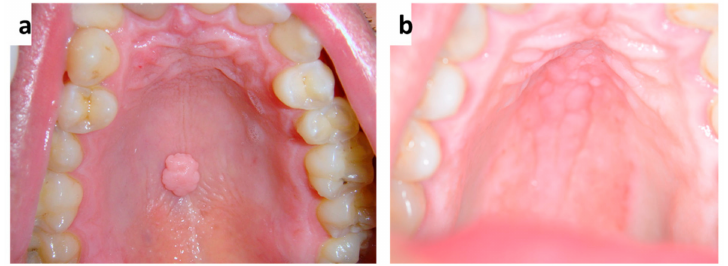
Figure 3. ( a , b ) Single ( a ) and diffuse ( b ) lesions of the palate related to Human Papillomavirus